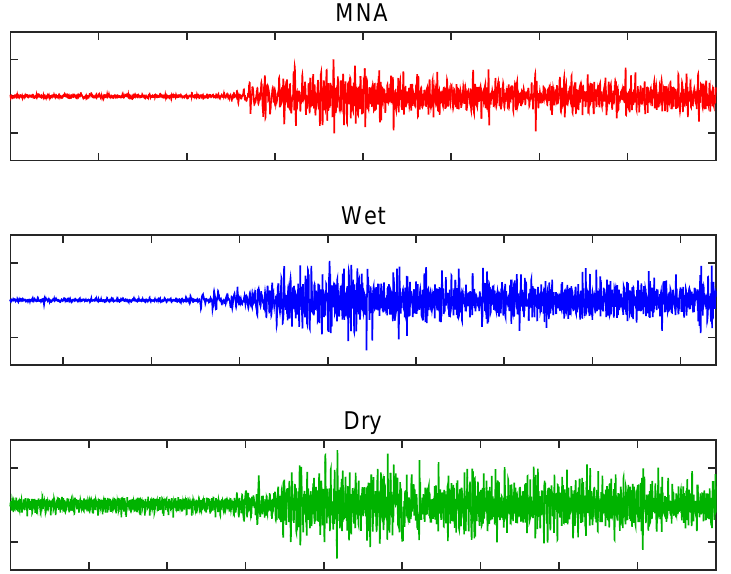
Figure 10. Measured sEMG signal during the maximum voluntary contraction from the FCR before the exercise. Signals were measured